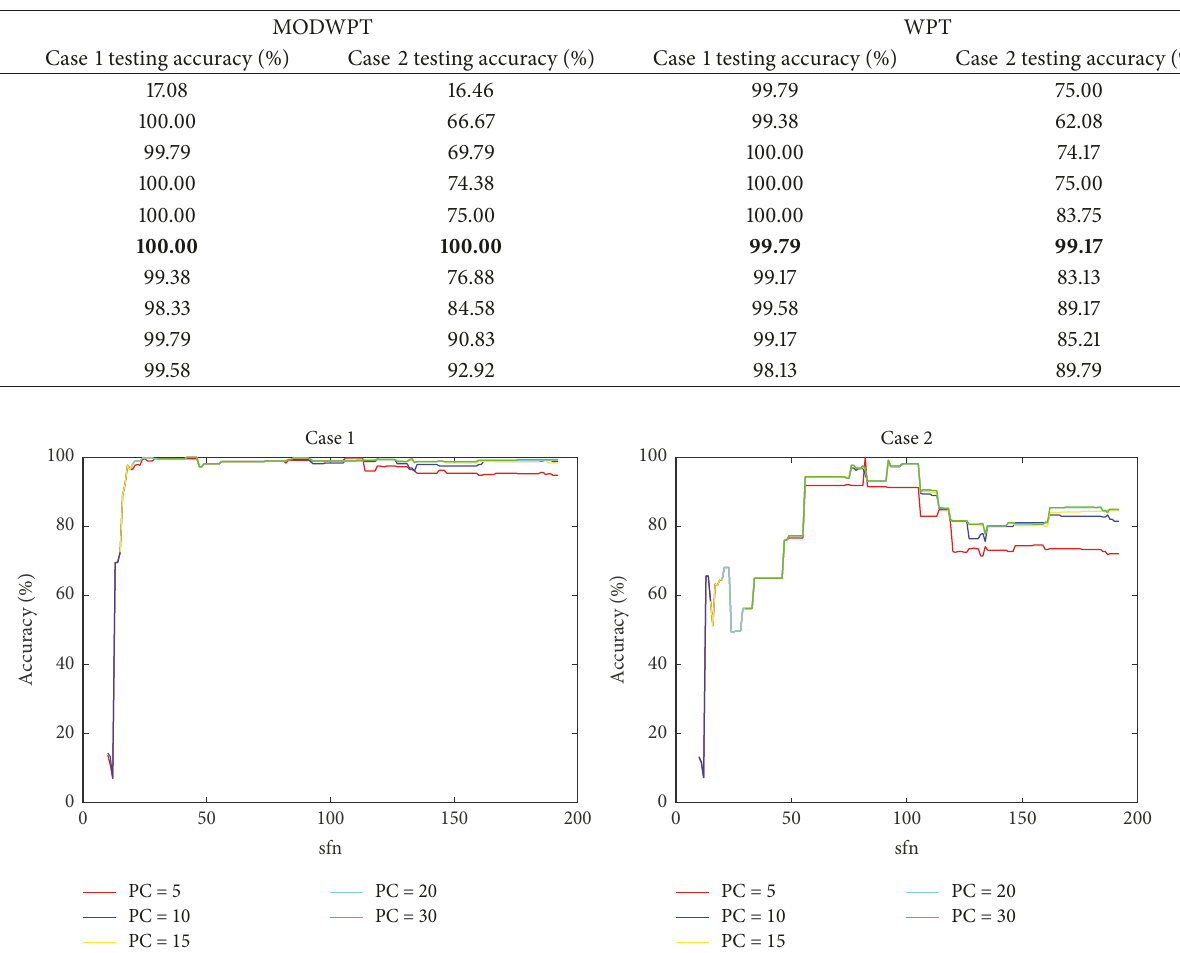
Figure 12: The diagnosis results obtained by OFS-FSASD-PCA-SVM using MODWPT with different dimension sizes for PCA. The PC represents the number of dimension